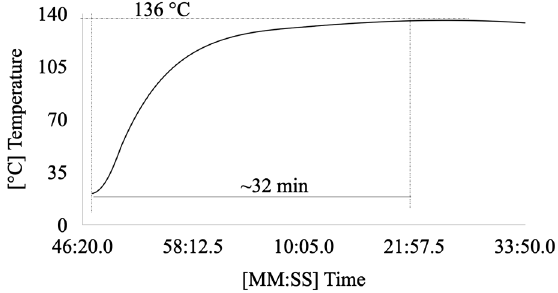
FIG. 19. Average PT100s temperature over time to steady state of the heating